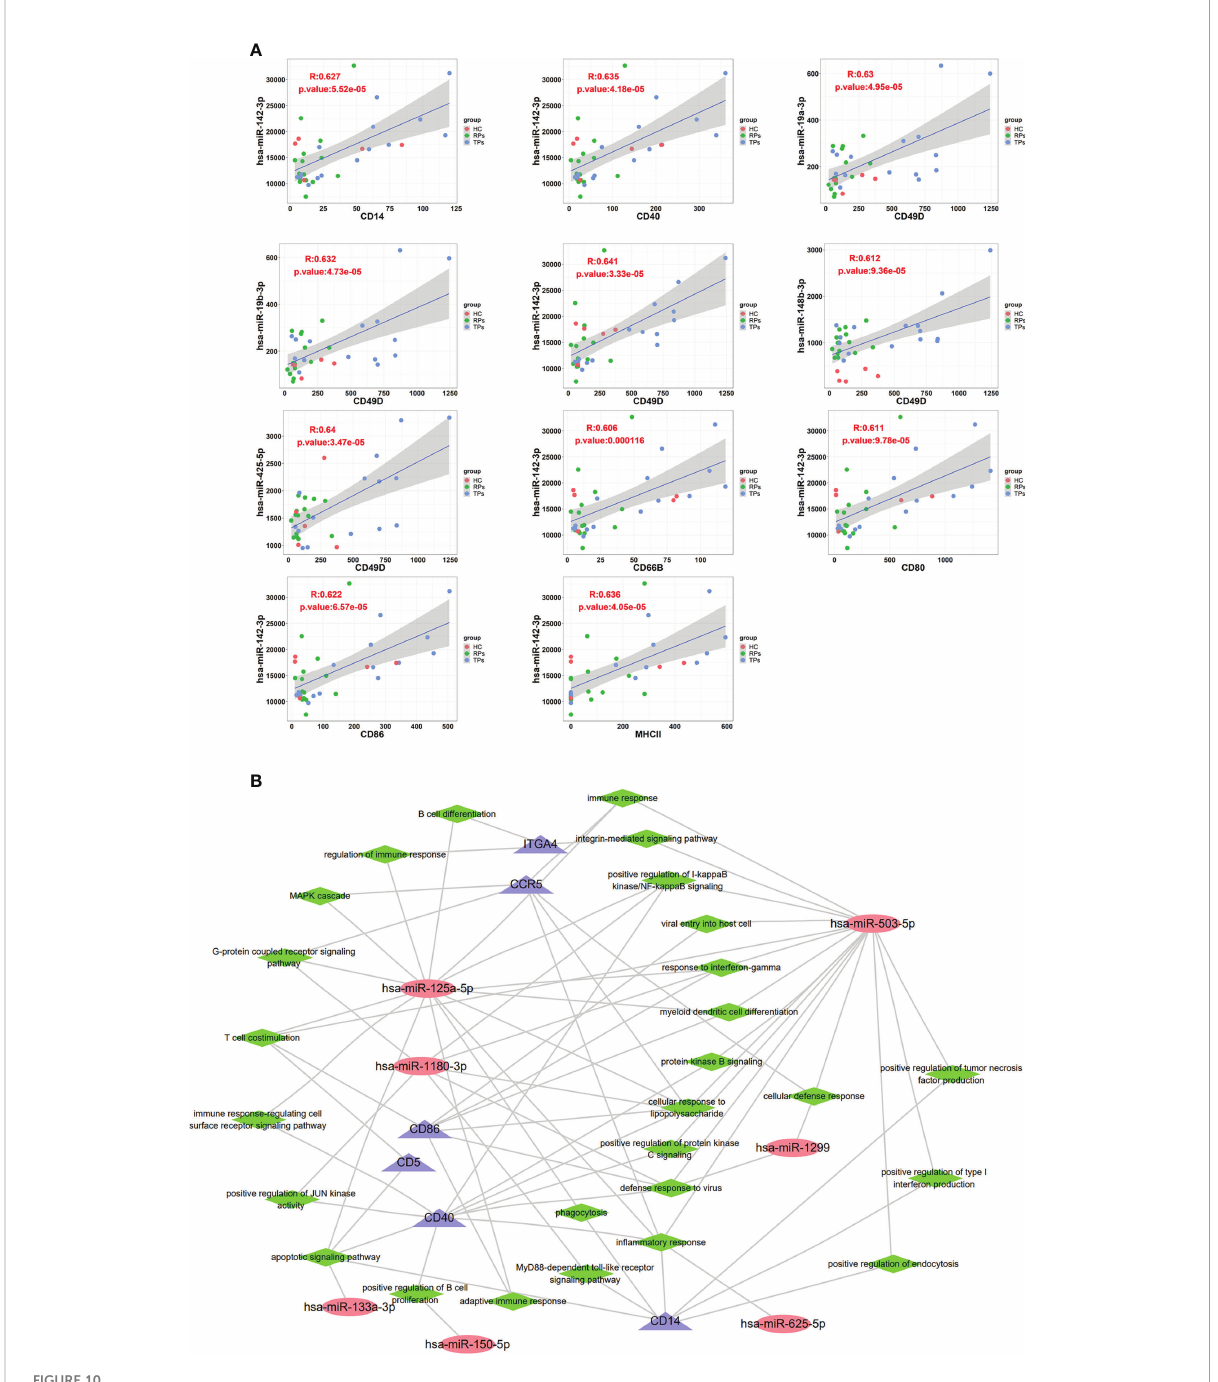
FIGURE 10 The correlation between exosome surface proteins and miRNAs. (A) The scatter plot of exosome surface proteins and miRNAs. (B) Exosomal miRNAs and surface proteins target the interaction regulatory network